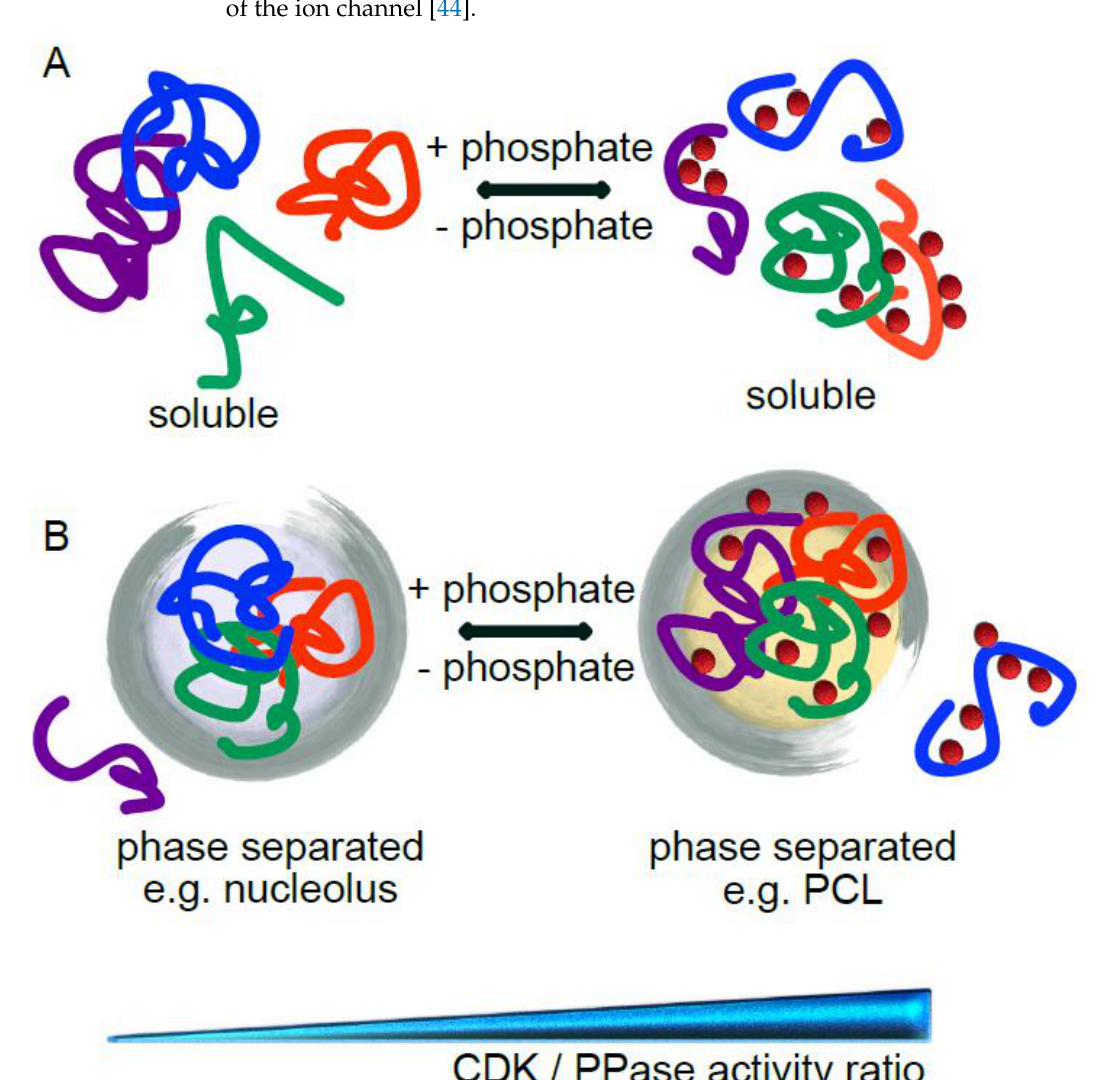
Figure 1. Phosphorylation controls the structure and function of IDRs in various ways. ( A ) Phos- phorylation can alter IDR conformation, inducing either folding or unfolding, thus affecting protein interactions. ( B ) CDK-mediated cell cycle-regulated phosphorylation acts as “dissolvase”, leading to dissolution of various MLOs (e.g., nucleoli) at the entry into mitosis, while inducing formation of other phase-separated compartments (e.g., perichromosomal layer, PCL), by regulating homotypic and heterotypic IDR interactions. Red circles indicate phosphorylation.